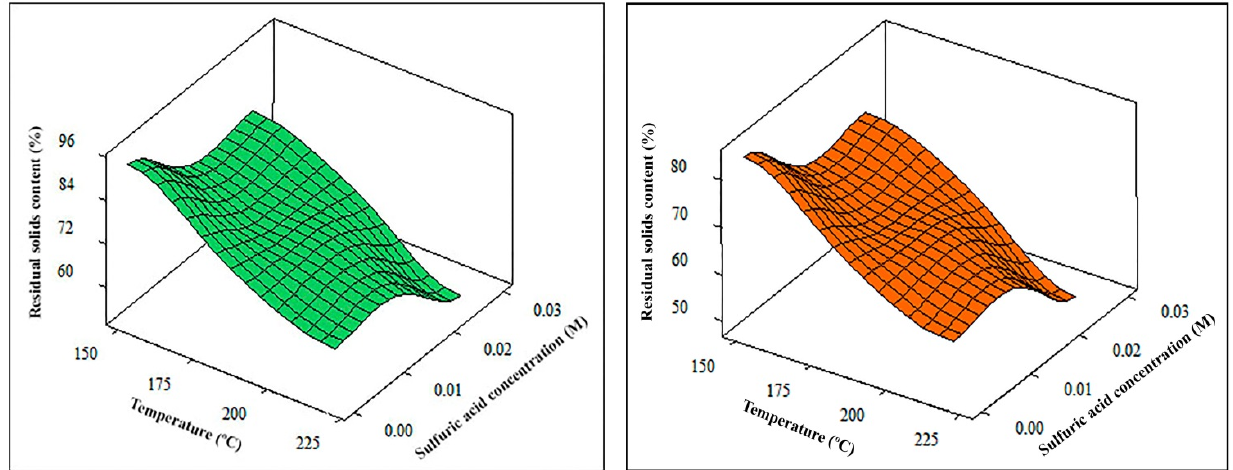
Figure 4. Response superficial for the solid recovery percentage in function of sulfuric acid concentration and temperature for young ( ) and old ( ) lifs during thermochemical process.